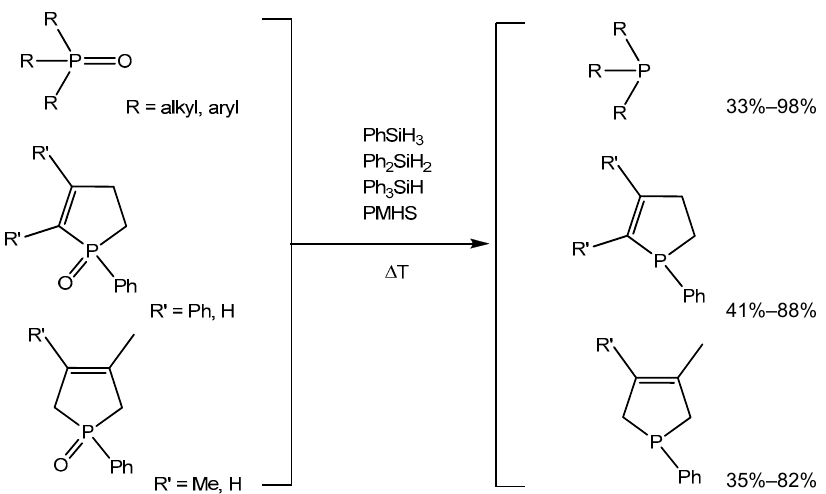
Scheme 2. Reduction of acyclic phosphine oxides and cyclic hydrophosphole oxides with